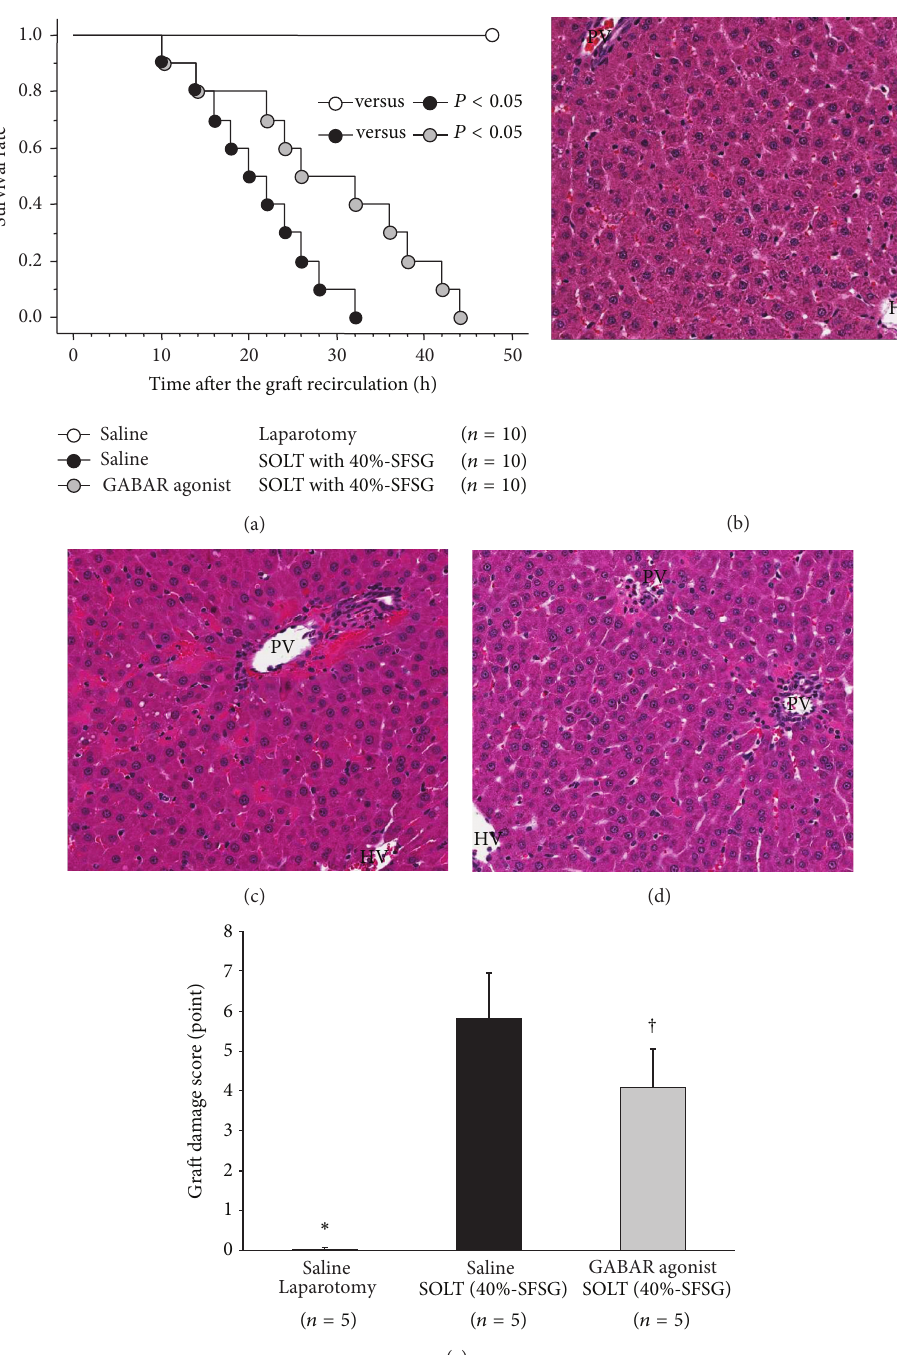
Figure 1: Survival curves, histopathological findings from HE staining, and graft damage scores. (a) Survival curves after SOLT with a 40%- SFSG. There were significant differences between laparotomy and SOLT with saline ( 𝑃 < 0.05 ∗ ) and between SOLT with saline and SOLT with GABAR agonist ( 𝑃 < 0.05 † ). (b) Laparotomy with saline: H-E, × 100. (c) SOLT with saline: H-E, × 100. (d) SOLT with GABAR agonist: H-E, × 100. (e) Graft damage score: There were significant differences between laparotomy and SOLT with saline ( 𝑃 < 0.05 ∗ ) and between SOLT with saline and SOLT with GABAR agonist ( 𝑃 < 0.05 † ). GABAR, 𝛾 -aminobutyric acid receptor; HE, hematoxylin-eosin; HV, hepatic vein; PV, portal vein; SFSG, small-for-size graft; and SOLT, split orthotopic liver